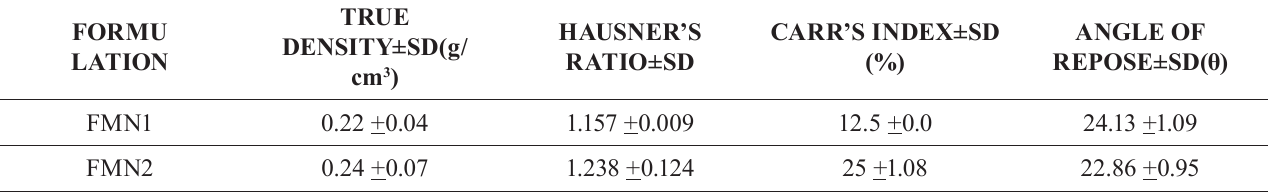
TABLE III - Results of true density, Hausner’s ratio, Carr’s index and angle of repose